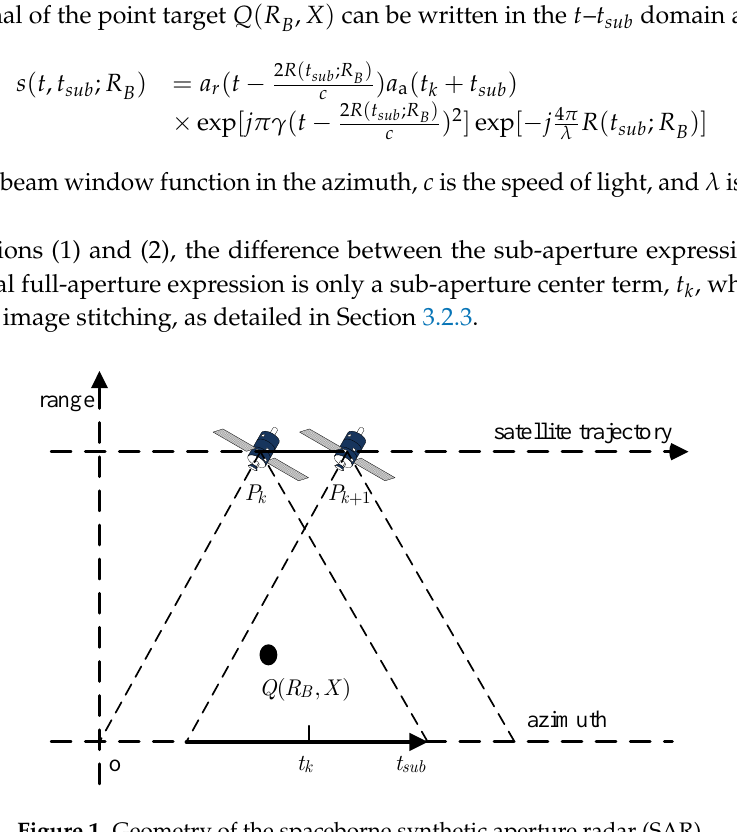
Figure 1. Geometry of the spaceborne synthetic aperture radar (SAR).